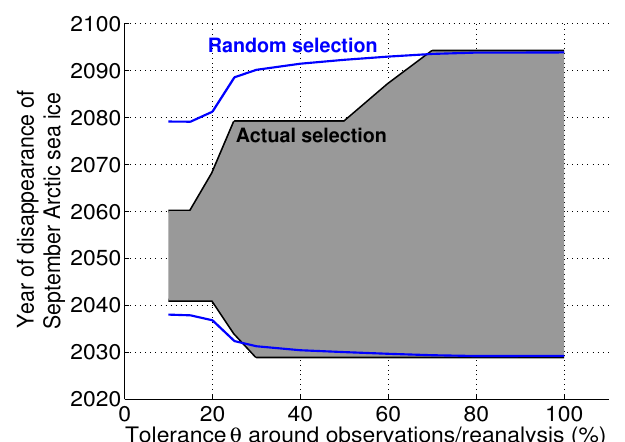
Fig. 6. Range of simulated years of disappearance of September Arctic sea ice, for RCP8.5. We define the year of disappearance of September Arctic sea ice as the first year during which the 5- yr smoothed September sea ice extent drops below 1 millionkm 2 for more than 5yr. A selection of models is applied following the methods defined in Sect. 3.4 for each tolerance θ around observa- tions/reanalysis. The black lines show the earliest and latest years of disappearance for the selected models as a function of θ . The blue lines show the corresponding range that is obtained on average by selecting the same number of models randomly (10000 draws) and ignoring the two models that are not ice-free by 2100 for which we do not have the year of summer Arctic sea ice